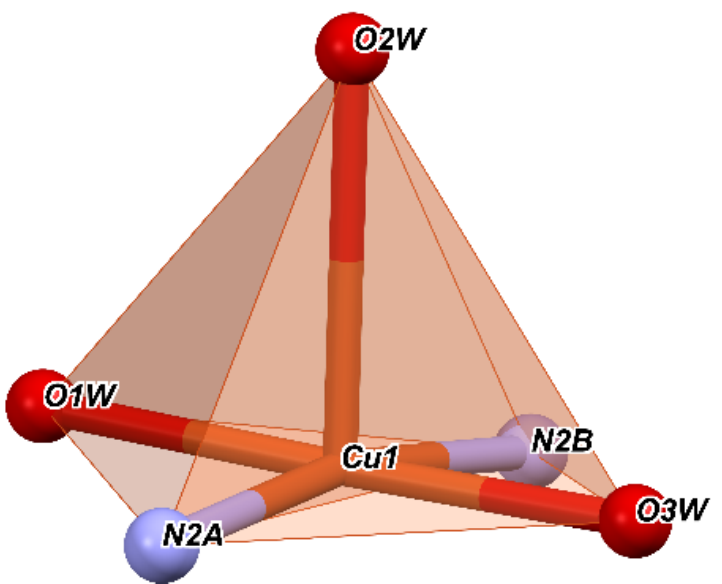
Figure 2. Coordination polyhedron of complex C1 .